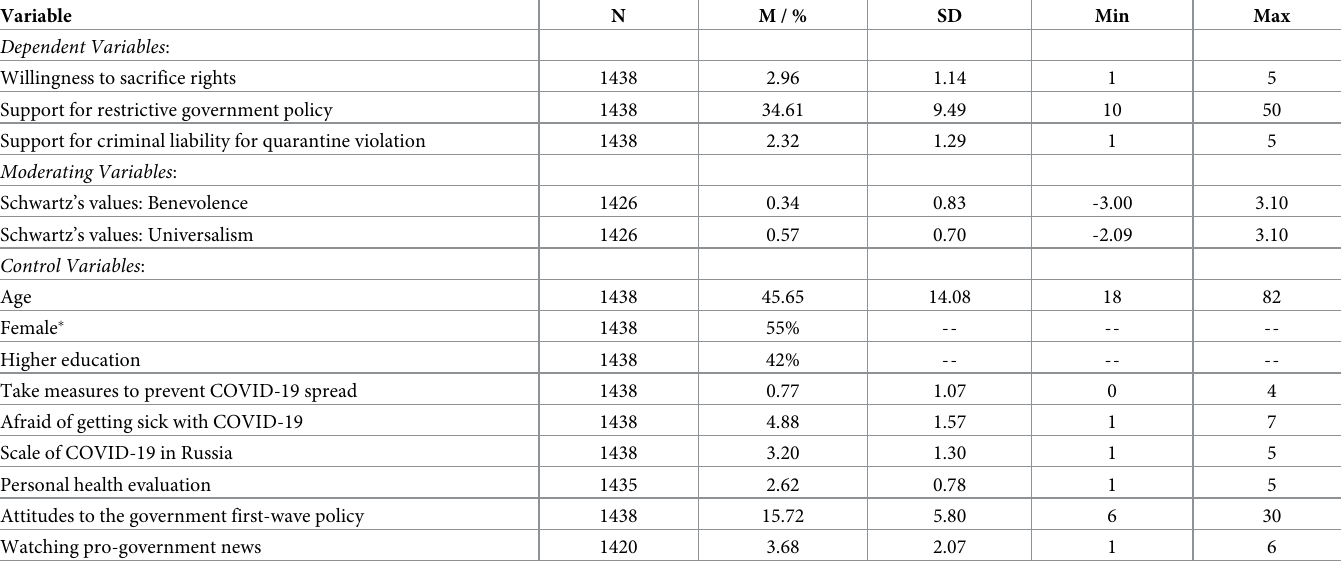
Table 6. Descriptive statistics of dependent variables and pre-treatment covariates.